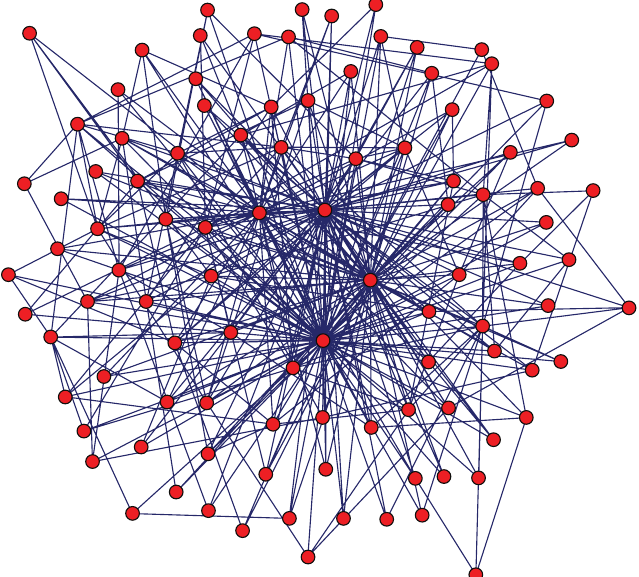
Figure 2: The scale-free network (cid:7) Barabasi-Albert extended model (cid:8) examined consists of 100 nodes and was generated by the networks software PAJEK (cid:4) 20 (cid:5) . The clustering coe ffi cient for the unweighted network is